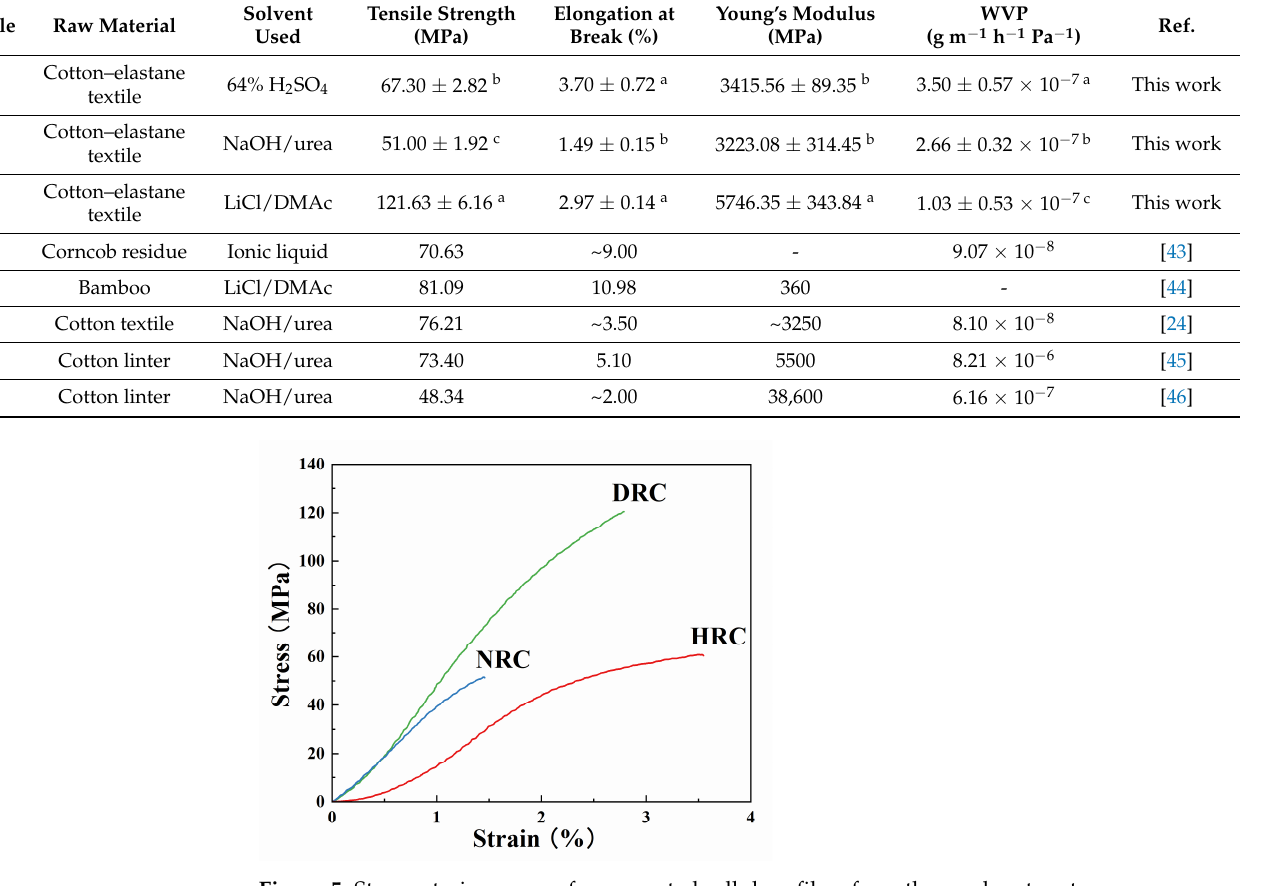
Figure 5. Stress–strain curves of regenerated cellulose films from three solvent systems.